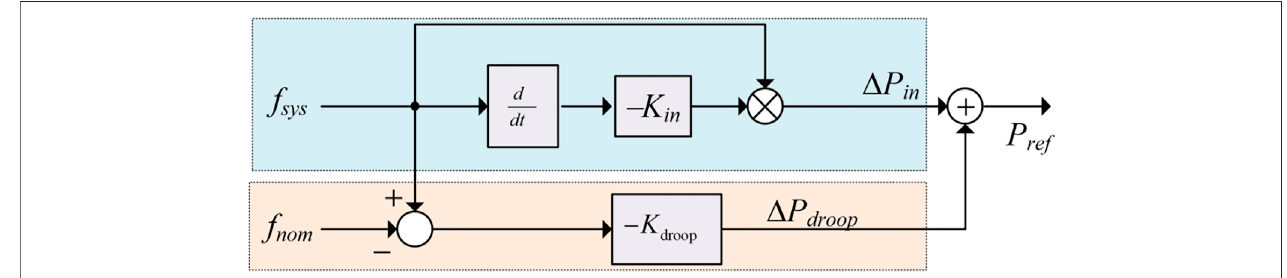
FIGURE 3 | Combined inertial control strategy of the BESS.